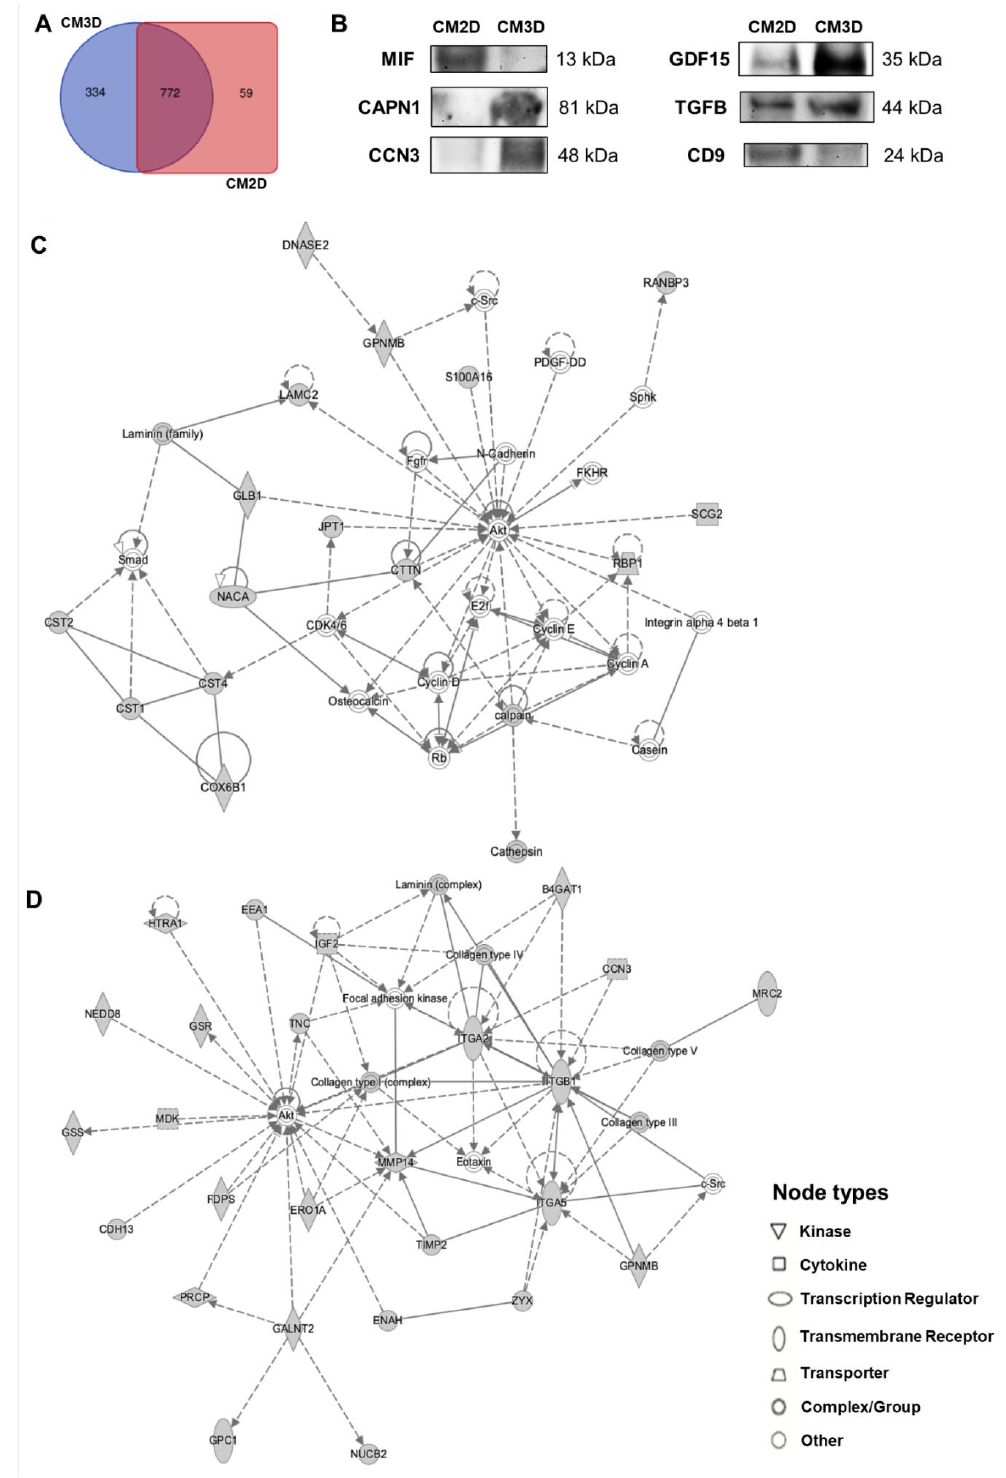
Figure 1. Proteomic profiling of MSC CM revealed the presence of proteins involved in cytoprotection. ( A ) Venn diagram shows the unique and shared protein numbers identified in CM3D and CM2D. ( B ) Confirmation of selected proteomic data by Western blot analysis of CAPN1, CCN3, MIF, GDF15, TGFB and CD9. ( C ) Network analysis of protein– protein interactions within CM3D with functions associated with cancer, carbohydrate metabolism and cardiovascular disease performed using the IPA software. ( D ) Network analysis of protein–protein interactions within CM3D unique and shared proteins with functions associated with the cardiovascular system development and function, cellular movement and tissue development performed using the IPA software. CM2D, conditioned medium derived from 2D cultures; CM3D, conditioned medium derived from 3D cultures; IPA, Ingenuity Pathway